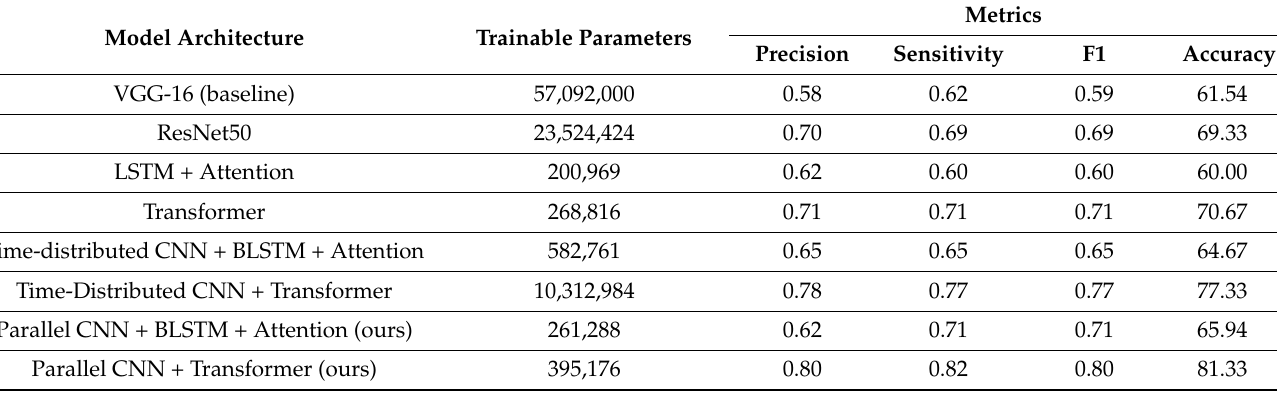
Table 5. Weighted average precision, sensitivity, F1 score, and accuracy of different models compared with parallel networks.